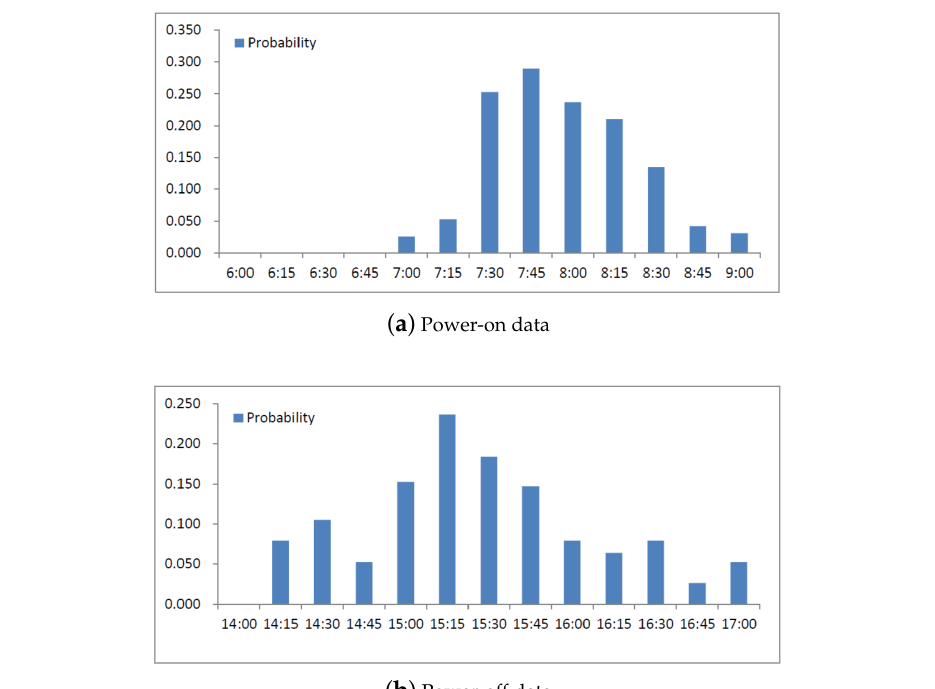
Figure 4. Action time probability distribution of the desktop